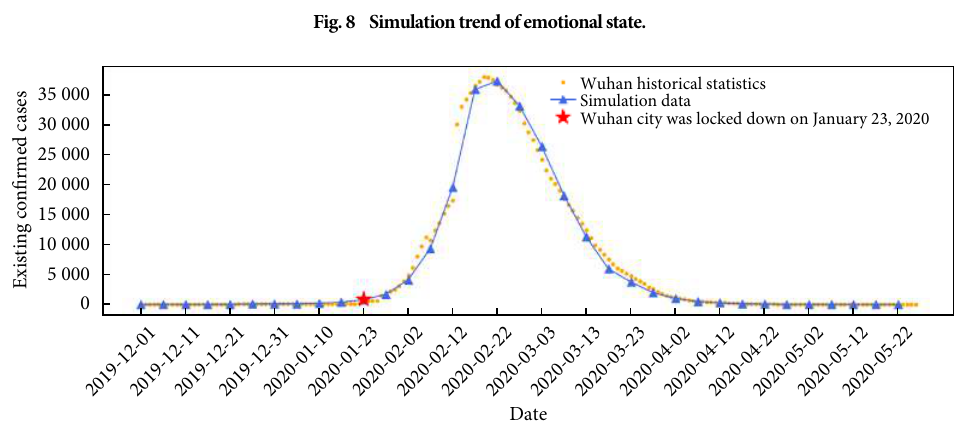
Fig. 8 Simulation trend of emotional state.